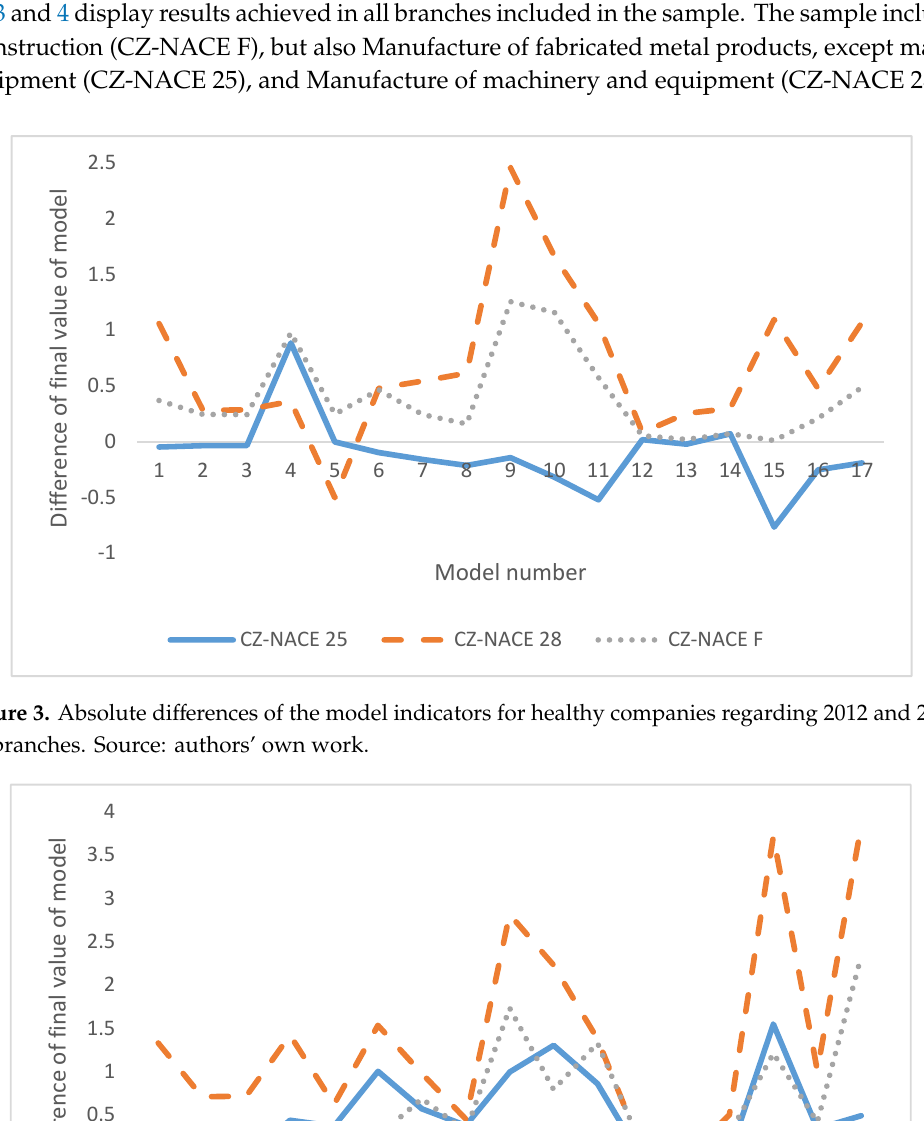
Figure 3. Absolute differences of the model indicators for healthy companies regarding 2012 and 2017 by branches. Source: authors’ own work.